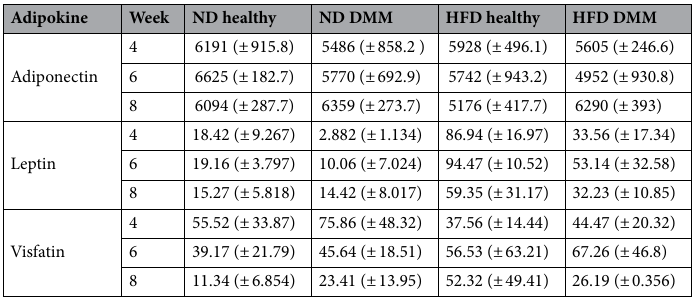
Table 1. Systemic adipokine levels in all treatment groups shown for all time points. Values are given as mean (± standard deviation) in